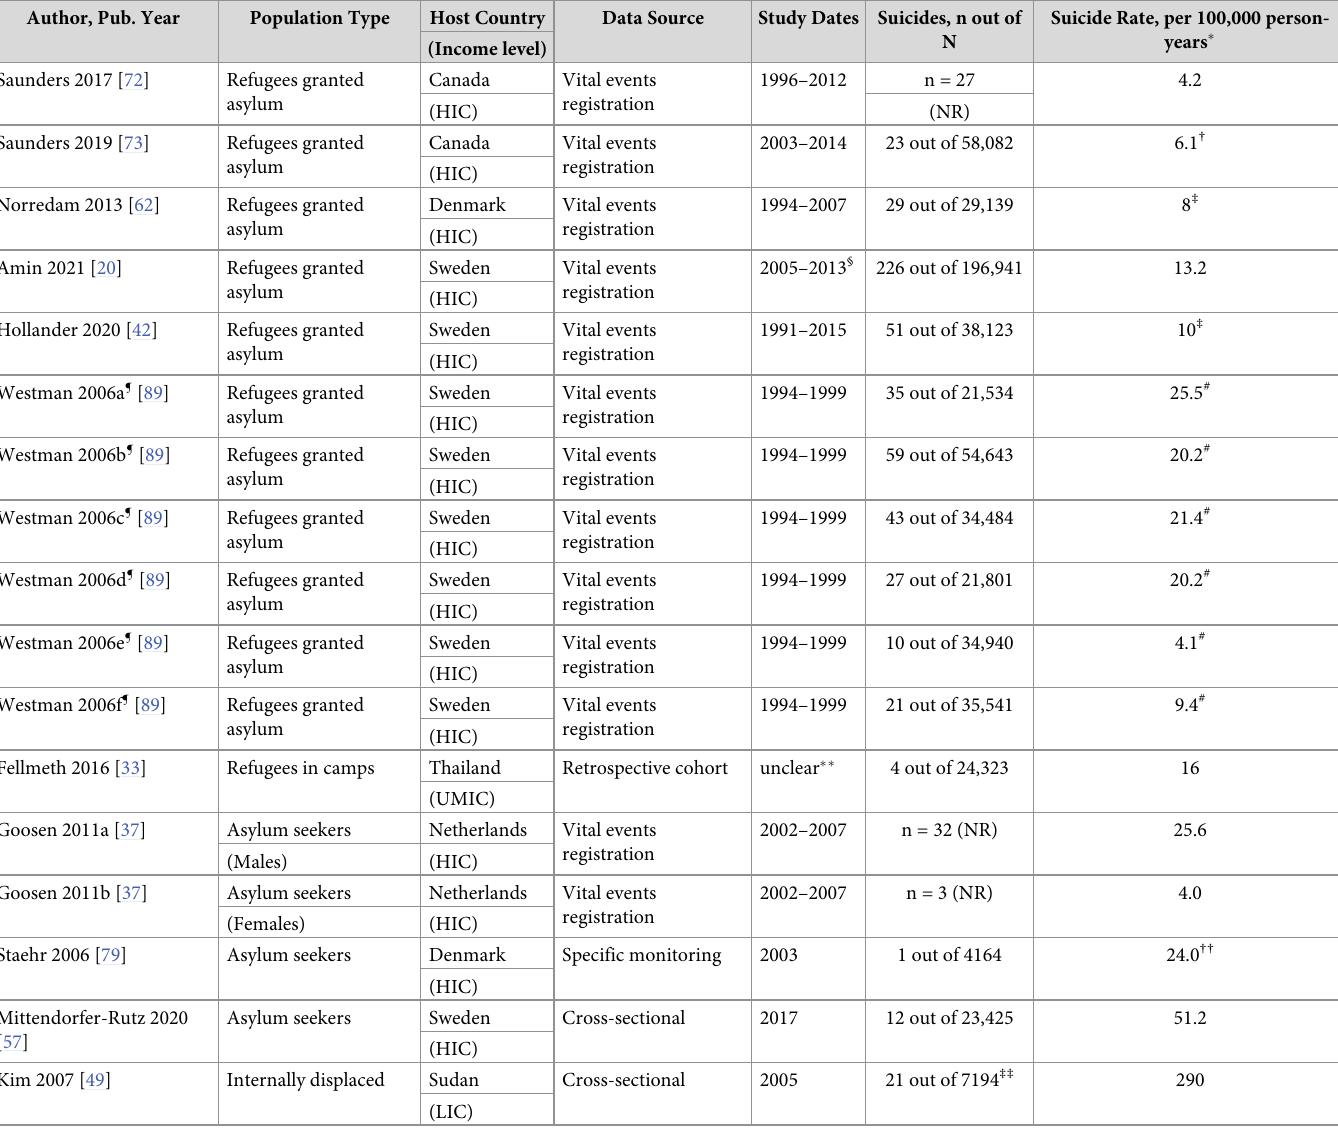
Table 2. Suicide rates per 100,000 person-years in general samples, grouped by population type (and then by data source and by host country). Author, Pub.